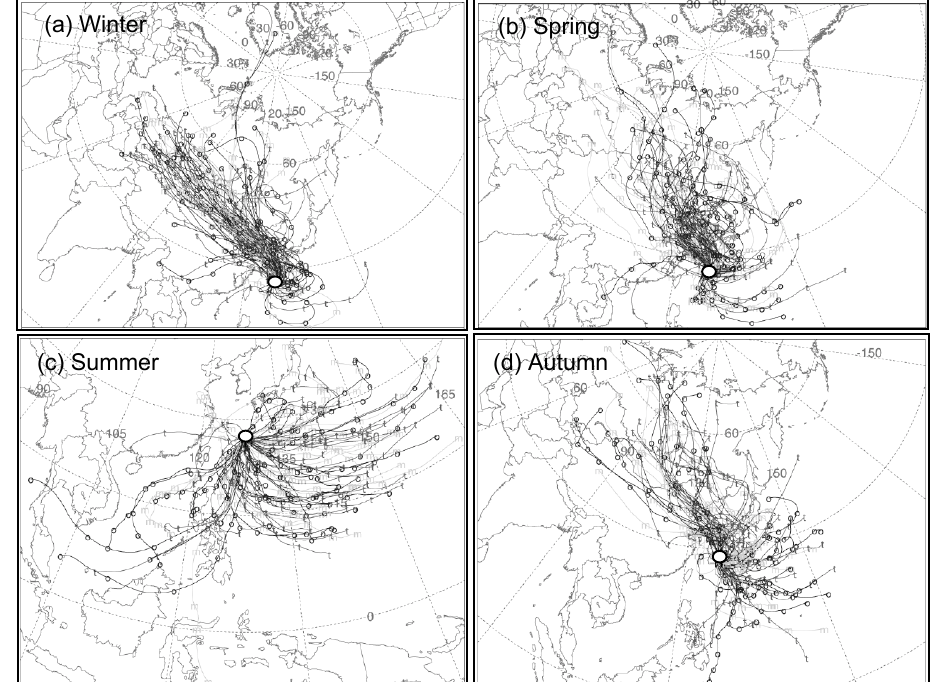
Fig. 2. Five-day backward trajectory analysis for four seasons; (a) winter (December, January and February), (b) spring (March, April and May), (c) summer (June, July and August), and (d) autumn (September, October and November). Backward trajectories at 500m above ground level were drawn with the NOAA HYSPLIT model. Table 1. Seasonal variations of mass concentrations of different organic components in aerosols from Cape Hedo, Okinawa.